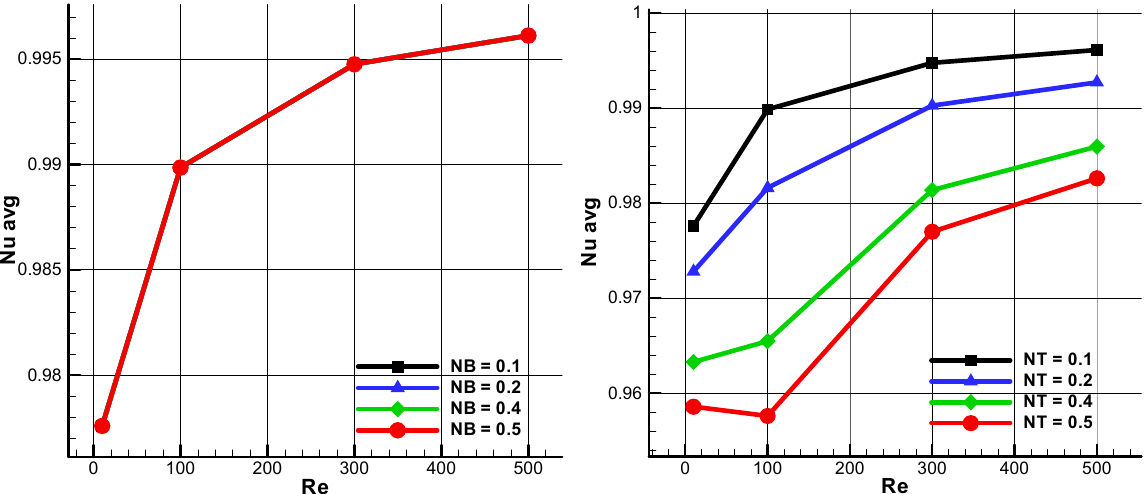
Figure 12. Average Nusselt number as a function of Re number for different N B number and Pr = 6.2, Le = 1, N T = 0.1 ( left ); Average Nusselt number as a function of Re number for different N T number and Pr = 6.2, Le = 1, N B = 0.1 ( right ).